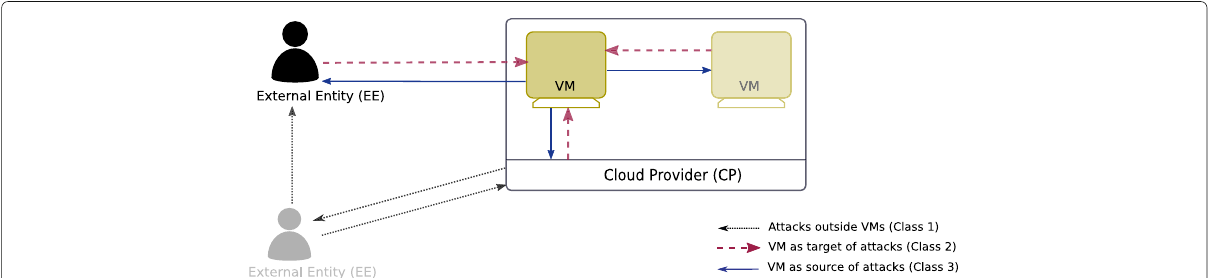
Fig. 1 A generic cloud scenario showing every actor, namely the EE, the CP, and the VM, as source or target of attack. Dashed red arrows represent a VM being a target and blue arrows represent a VM being source of attacks. Dotted arrows represent directions of attacks that do not involve